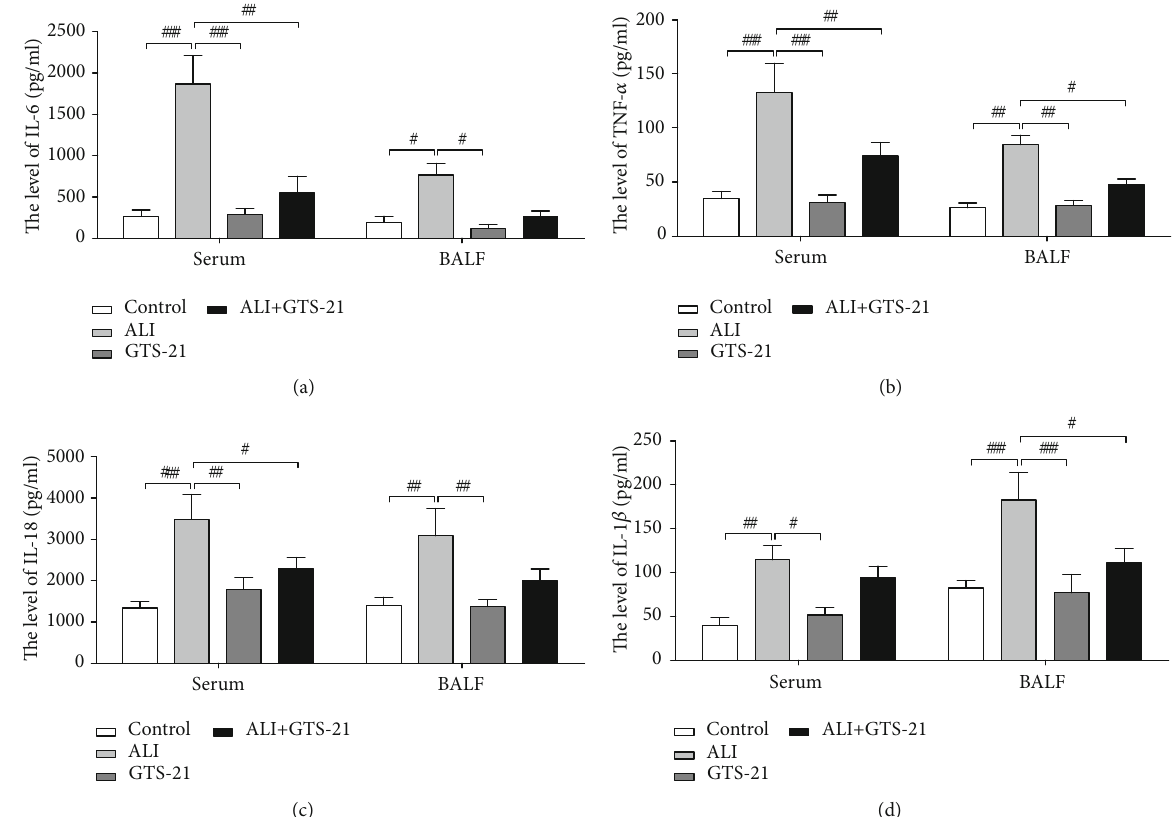
Figure 2: GTS-21 administration reduced the releases of DC-related proin fl ammatory cytokines in the serum and BALF of sepsis-induced ALI mice. (a – d) The productions of cytokines IL-6, TNF- α , IL-18, and IL-1 β in the serum and BALF were measured by ELISA. n = 4 – 6 mice/group. All data are shown as mean ± SD . # p < 0 : 05 , ## p < 0 : 01 , ### p < 0 : 001